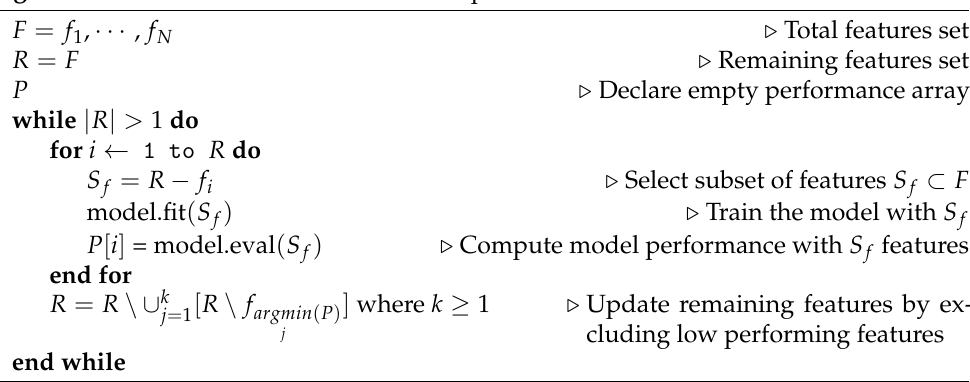
Algorithm 1 Backward Feature Elimination procedure used to reduce features in